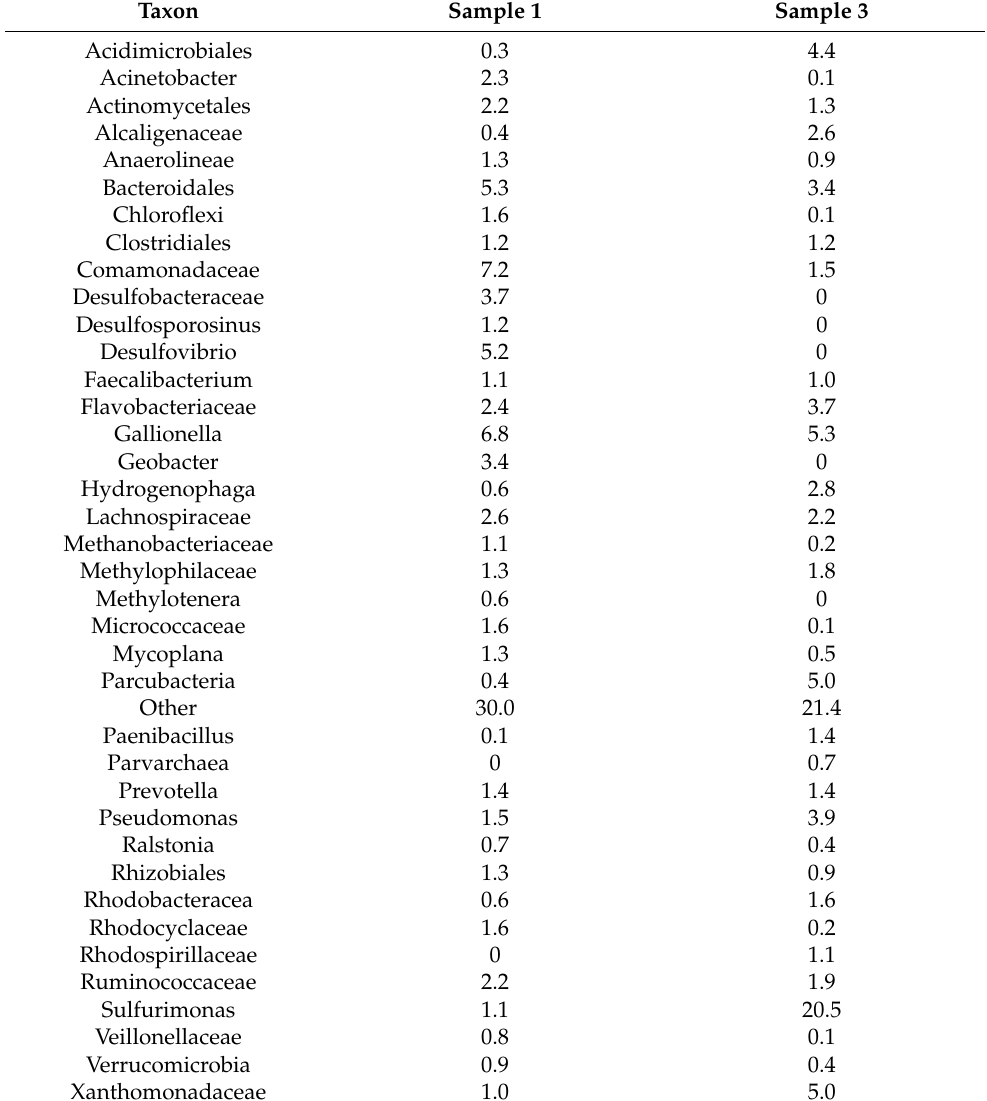
Table 3. Heat map of 16S rRNA gene analysis results for Samples 1 and 3 (part 1). (% of the total number of operational taxonomic units—OTUs).